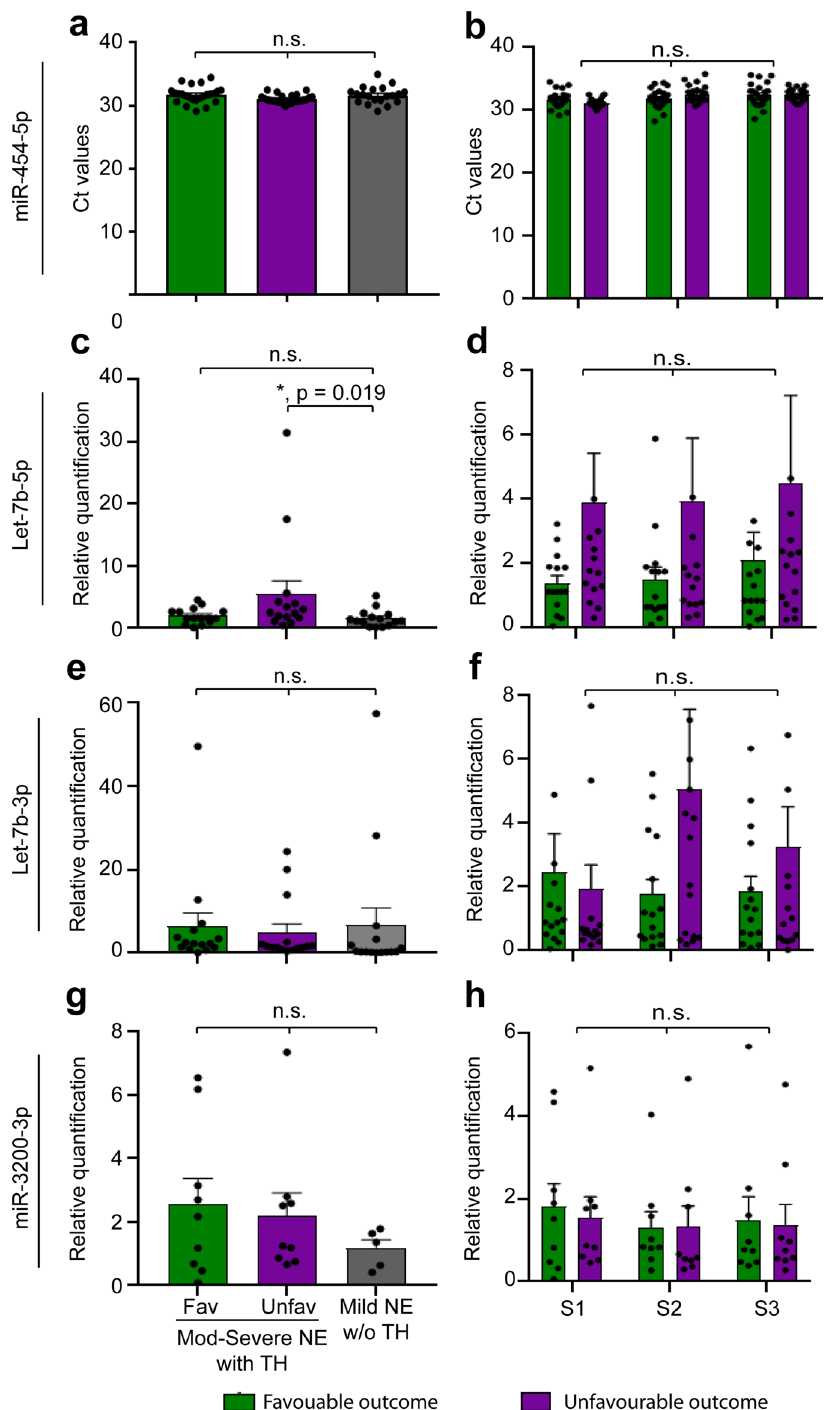
Fig. 3 Expression of control and candidate miRNAs in neonates with encephalopathy. a, c, e and g show the expression of miR-454-5p, let-7b-5p, let-7b- 3p and miR-3200-3p respectively in all groups at S1 samples. Similarly graphs b, d, f and h show the temporal expression of miR-454-5p, let-7b-5p, let-7b- 3p and miR-3200-3p, respectively, at various time points (S1, S2 and S3 samples) in neonates with moderate to severe NE with TH and favourable and unfavourable outcome. Green bars represent favourable outcome, while purple bars represent unfavourable outcome. Neonates with mild NE not receiving TH were denoted in grey bars. Relative quanti fi cation denotes 2 - ΔΔ Ct of the candidate miRNAs in comparison to endogenous control miRNA, miR-454-5p. Column graphs showing mean with error bars representing SEM. ns, not signi fi cant; * denote p < 0.05 using Kruskal – Wallis test for nonparametric data. Each group consists of n = 15 neonates. NE neonatal encephalopathy, TH therapeutic hypothermia, Fav favourable outcome, Unfav unfavourable